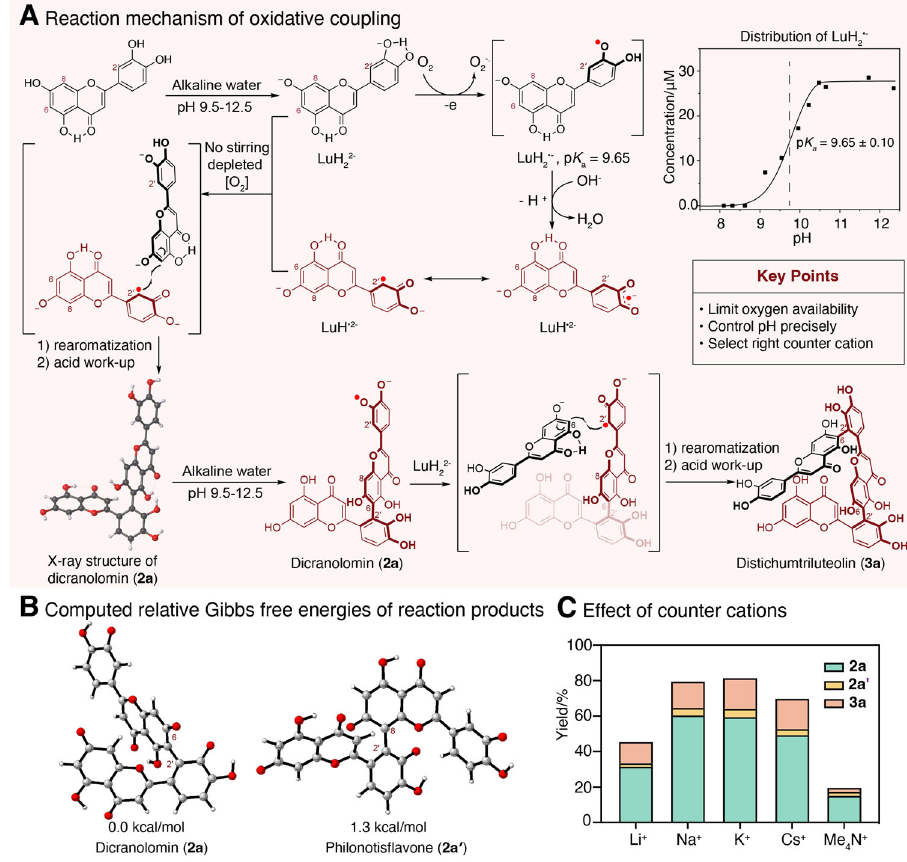
Fig. 7 | Reaction mechanism and computational study of regioselectivity. A Proposed mechanisms for oxidative coupling reactions, counter-cations are